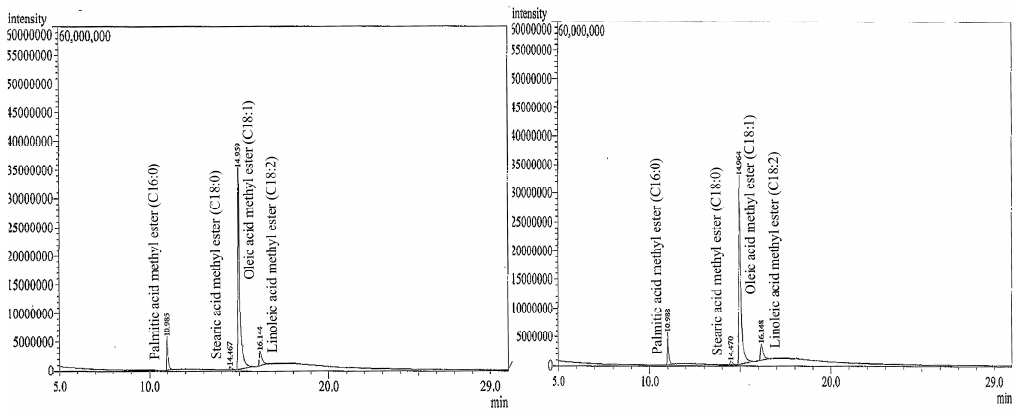
Figure 4. GC-MS chromatograms of tea seed oil ( left ) and SEOF (A1) ( right ) after transesterification. Table 2. Levels (%) of fatty acid composition obtained from tea seed oil and SEOF.